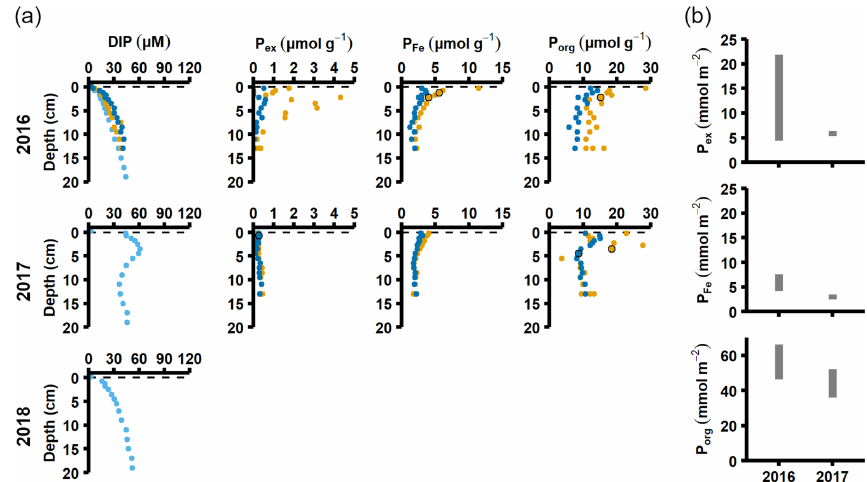
Figure 4. Pore water and sediment solid-phase data from station D. (a) Profiles of pore water DIP, solid-phase exchangeable or loosely sorbed P (P ex ), easily reduced or reactive iron-bound P (P Fe ) , and organic P (P org ). Profiles with light blue markers are from big sediment cores (inner diameter 9.9cm), and profiles with dark blue and orange markers are from replicate small sediment cores (inner diameter 6cm). Markers with black edges are missing data that have been replaced with average concentrations from the slices directly above and below (see Appendix B). (b) Excess inventories (min–max range) of P ex and P Fe and inventories of P org in the top